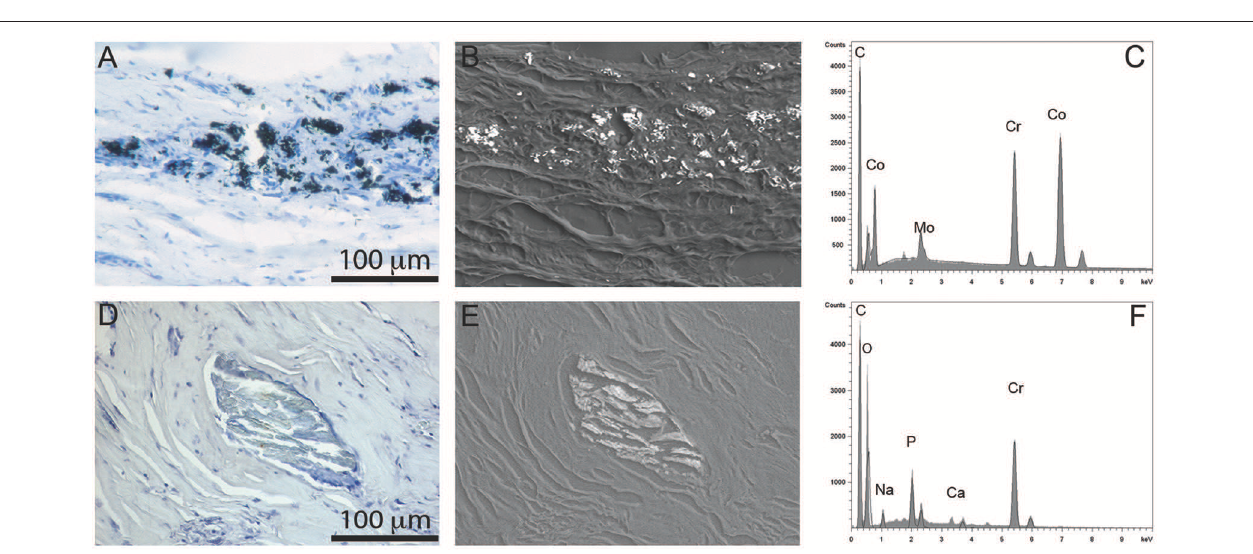
FIGURE 4 | Particles observed in periprosthetic tissues. (A–C) CoCrMo metal particles of sub-micron size group in leukocyte infiltrated areas (A) ; they show a high contrast in back-scattered electron image due to their high density (B) ; the EDS spectrum shows peaks of Co, Cr, and Mo (C) . (D–F) chromium phosphate particles, tens to hundreds of microns in size usually surrounded by a collagenous capsule (D) , showing low density in back scattered electron image (E) , and peaks in Cr, O, and P in EDS spectrum (F)